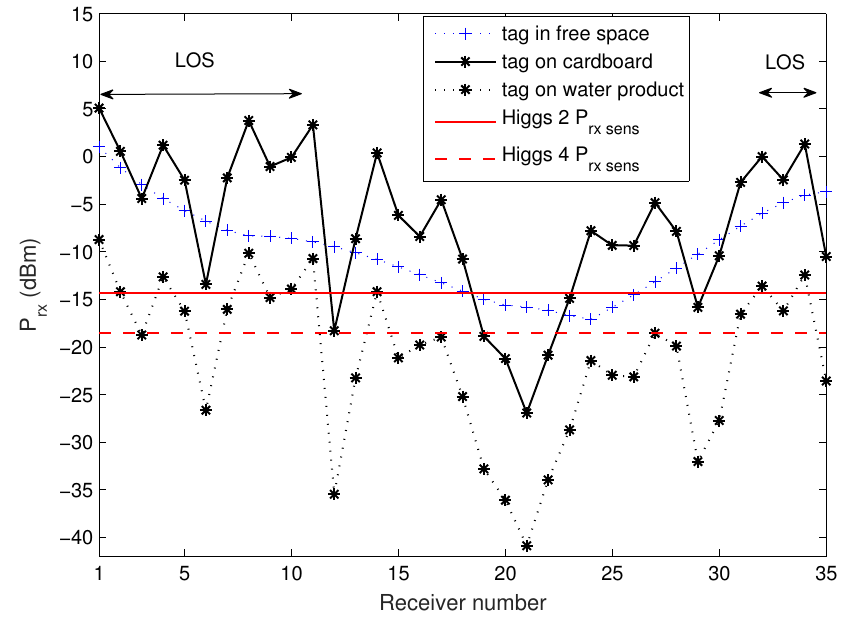
Figure 13. Simulation results of P tag variation along the receiver